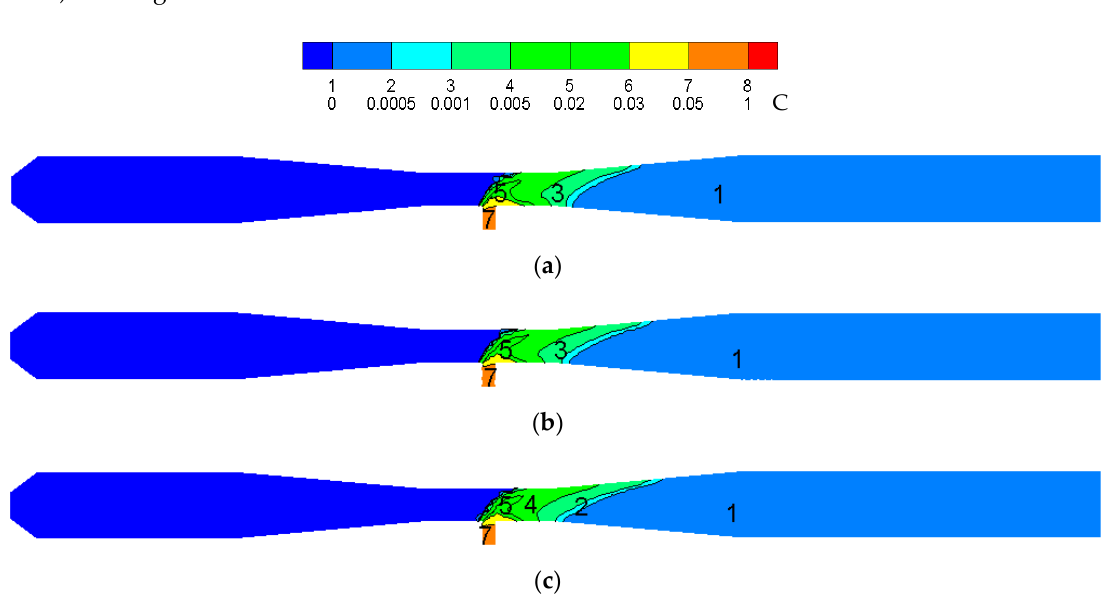
Figure 6. The comparison of concentration distribution of CeCl 3 in the reactor after amplification: ( a ) magnified by 8 times ( b ) magnified by 10 times ( c ) magnified by 12 times.